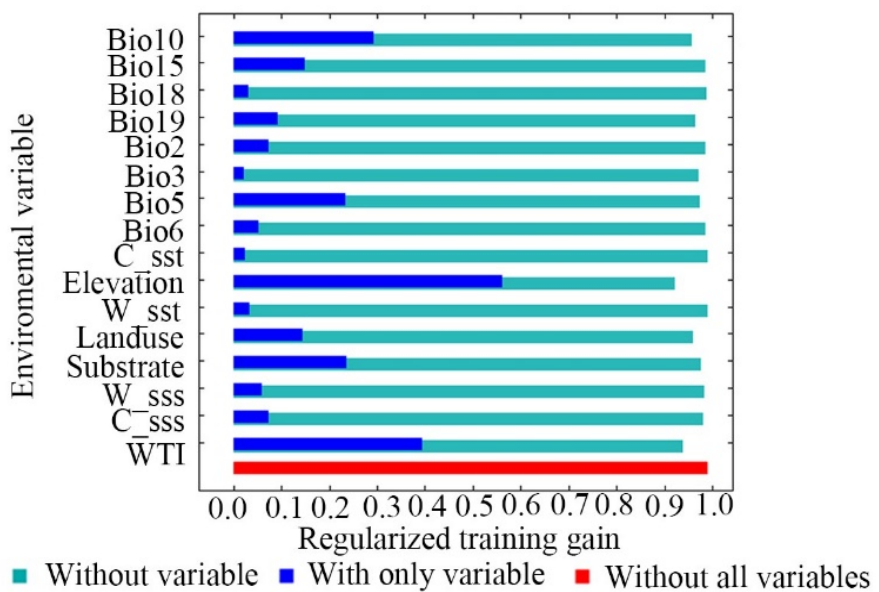
Figure 7. The regularized training gains of the combined mangrove distribution. Dark blue entries represent independent test results of each variable, light green entries represent test results excluding